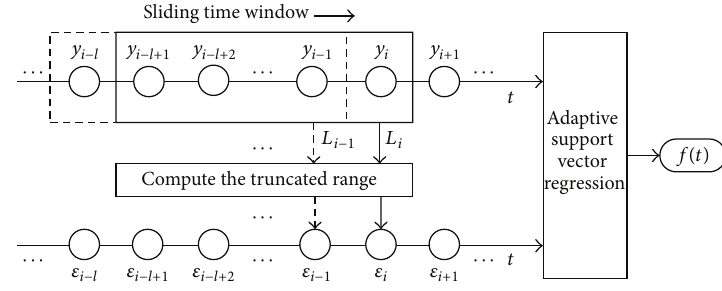
Figure 2: Schematic diagram of